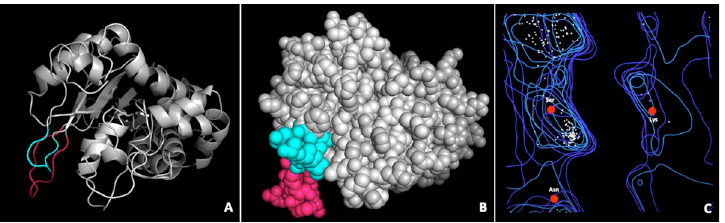
Fig 5. Stereo representation (a), ribbon diagram (b) and Ramachandran plot (c) of modeled structure of P . domestica S 17 -RNase (magenta), and P . domestica SI-RNase (cyan), showing secondary structural elements and